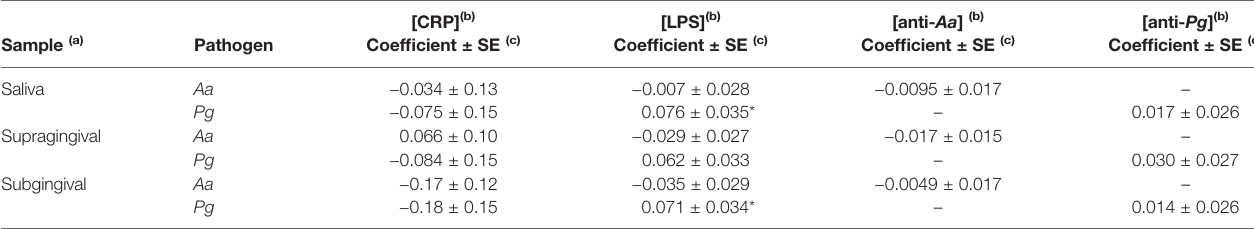
TABLE 4 | Relationship between periodontal pathogens in saliva, supragingival plaque, and subgingival plaque with the concentrations of the Aa and Pg antibodies, CRP and LPS.